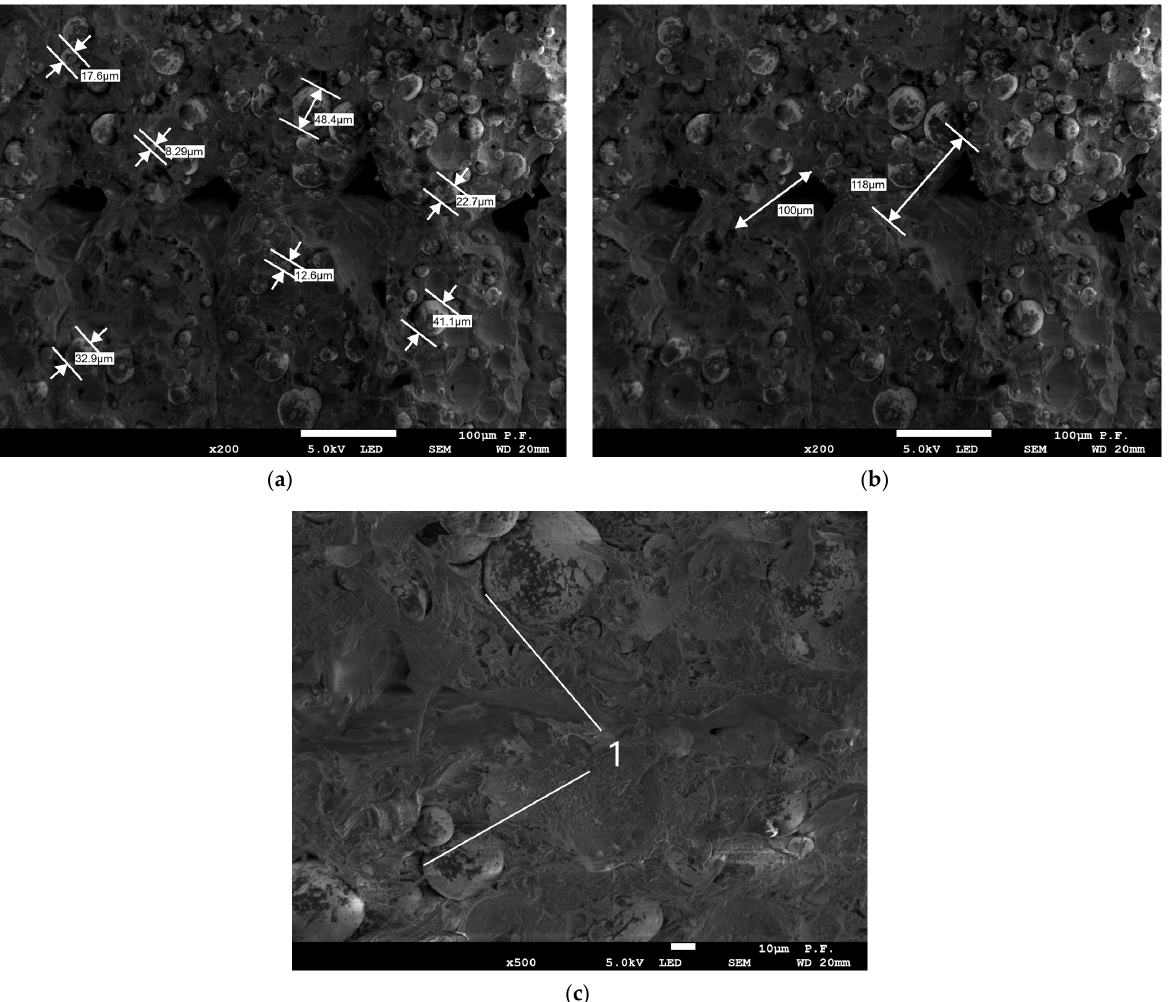
Figure 11. Cross-section of specimen 4.0 2Y composed of PLA + bronze after fracture analysed with a scanning electron microscope; ( a ) observation direction—perpendicular to the cross-section; diameters of the bronze powder grains; magnification ×100; ( b ) observation direction—perpendicular to the cross-section; gap sizes; magnification ×100; ( c ) observation direction—at an angle of 45° to the cross-section; magnification ×100.